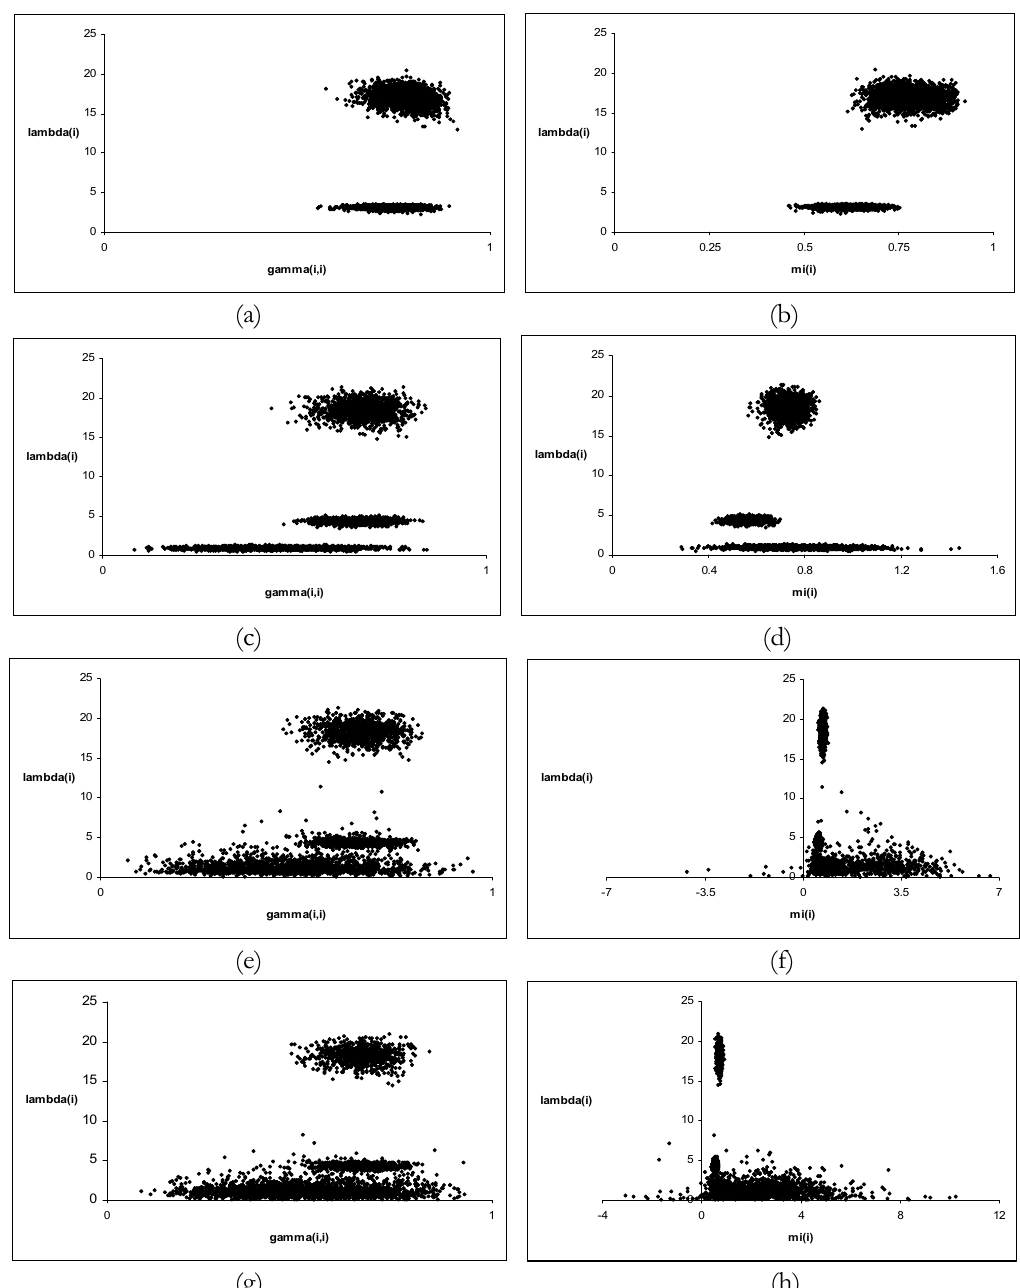
Figure 2 – Some outputs of unconstrained Metropolis-within-Gibbs algorithm with random permu- tations for p =2 and m =2 (a; b), m =3 (c; d), m =4 (e; f), m =5 (g;